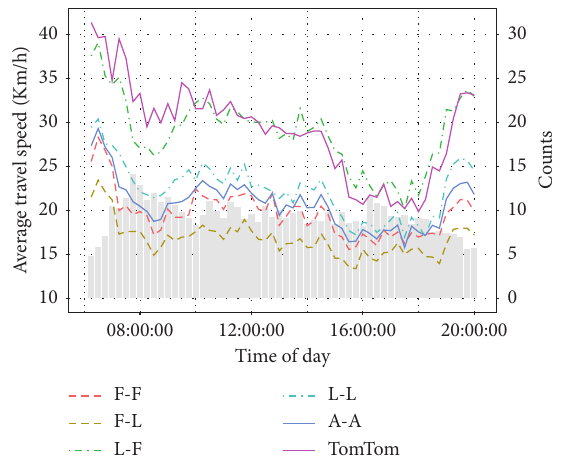
Figure 15: The comparison of five BTaverage speeds and TomTom average speed of link